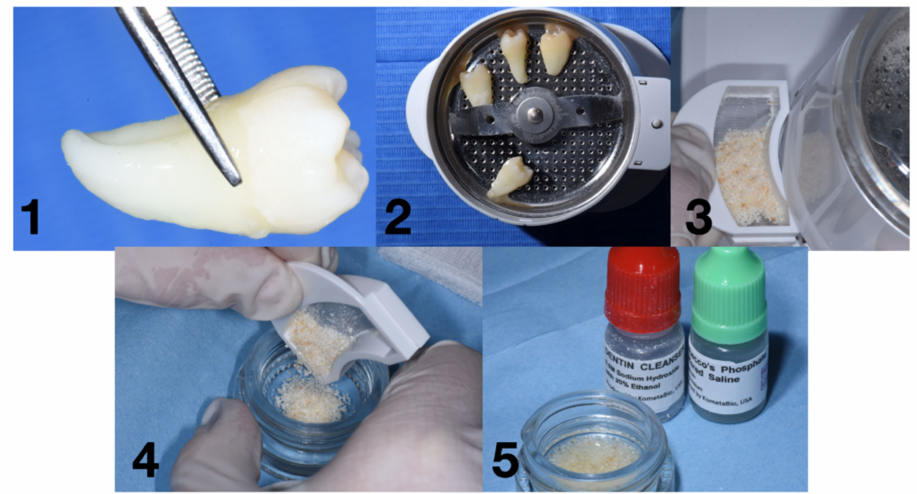
Figure 5. Workflow for the Smart Grinder protocol: ( 1 ) removal of tartar and periodontal ligament Figure ( 2 ). milling process, ( 3 ) particles ready to be chemically treated, ( 4 ) particles in the mixing dish, and ( 5 ) particles after the chemical